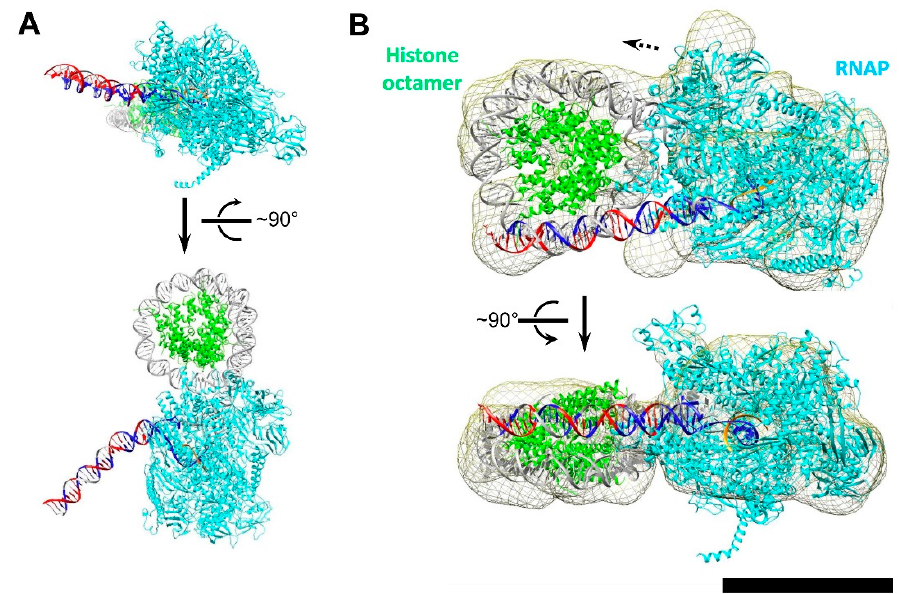
Figure 6. Modeling structure of EC+20 containing ssDNA break into electron density obtained by single particle EM. ( A ) Reconstitution of the EC+20 by fitting structures of nucleosome core particle and E. coli RNAP EC (PDB 3LZ0 and 4JKR, respectively). Nucleosomal DNA was connected to DNA localized downstream of the active center of RNAP. The color code is the same as in Figure 4C. Upstream DNA: blue is decreased sensitivity, red is increased sensitivity to DNase I and hydroxyl radicals. The docking of the molecular model of EC+20 complex into 3D density resulted in cross- correlation coefficient 0.73. ( B ) Model of intact EC+20. Color code: RNAP is cyan, histones are green, RNA strand is orange, DNA is grey. Scale bar – 10 nm. Two different orientations of the complexes rotated by ~90 degrees relative to each other are shown.